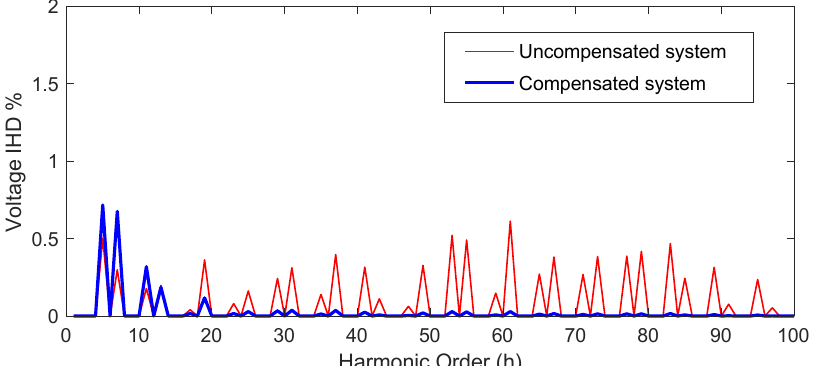
Figure 10. Figure 10. The PoC voltage spectrum prior and after installing the PPF proposed by the MRFO al- gorithm.